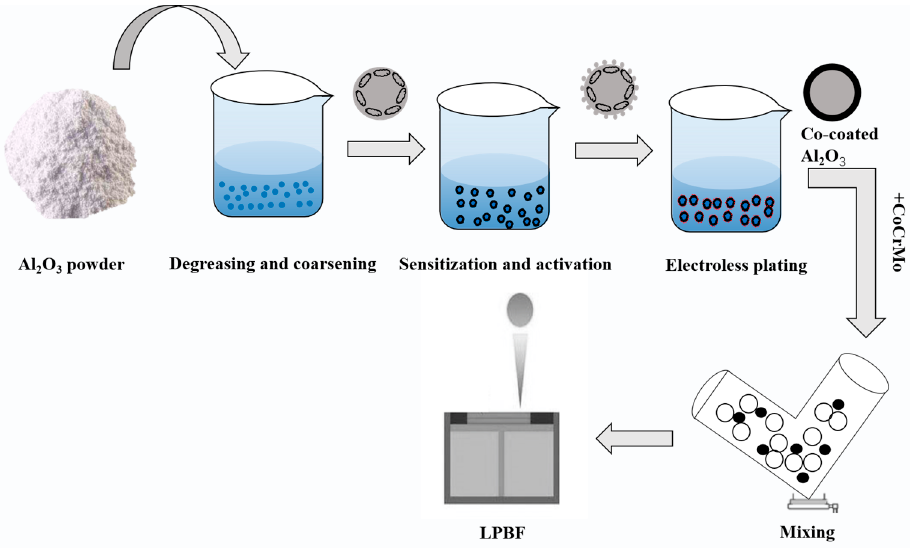
Figure 2. Schematic representation of electroless Co plating and LPBF process.